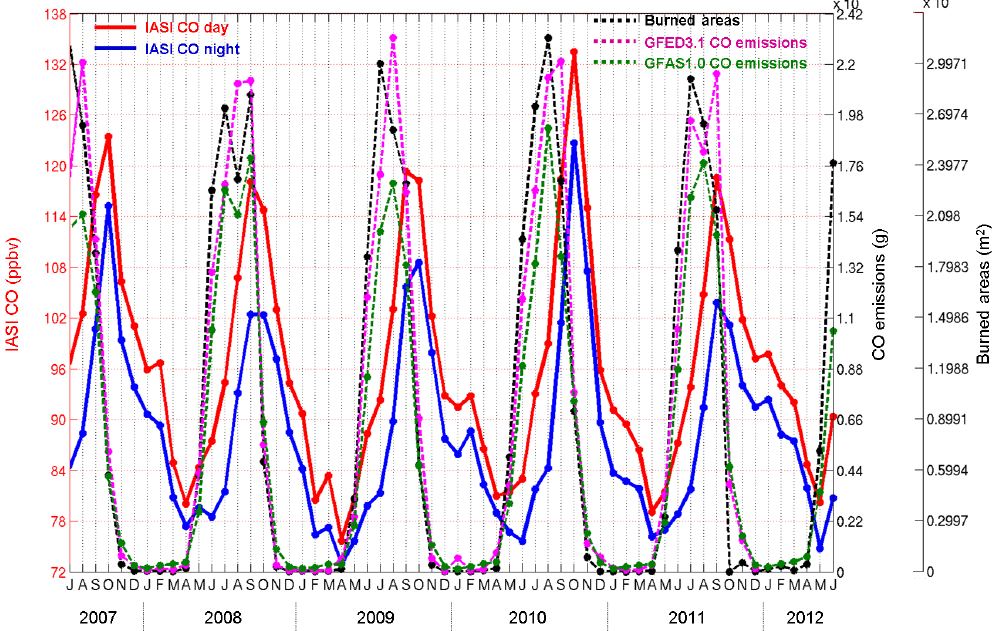
Figure 3. Evolution of the integrated content of CO from IASI on land and of fires between July 2007 and June 2012 in southern Africa (0–20 ◦ S, 0–53 ◦ E). Red: CO by day (09:30LT). Blue: CO by night (21:30LT). Black dashed: MODIS burned areas. Purple dashed: CO emissions from GFED3.1. Green dashed: CO emissions from GFAS1.0.